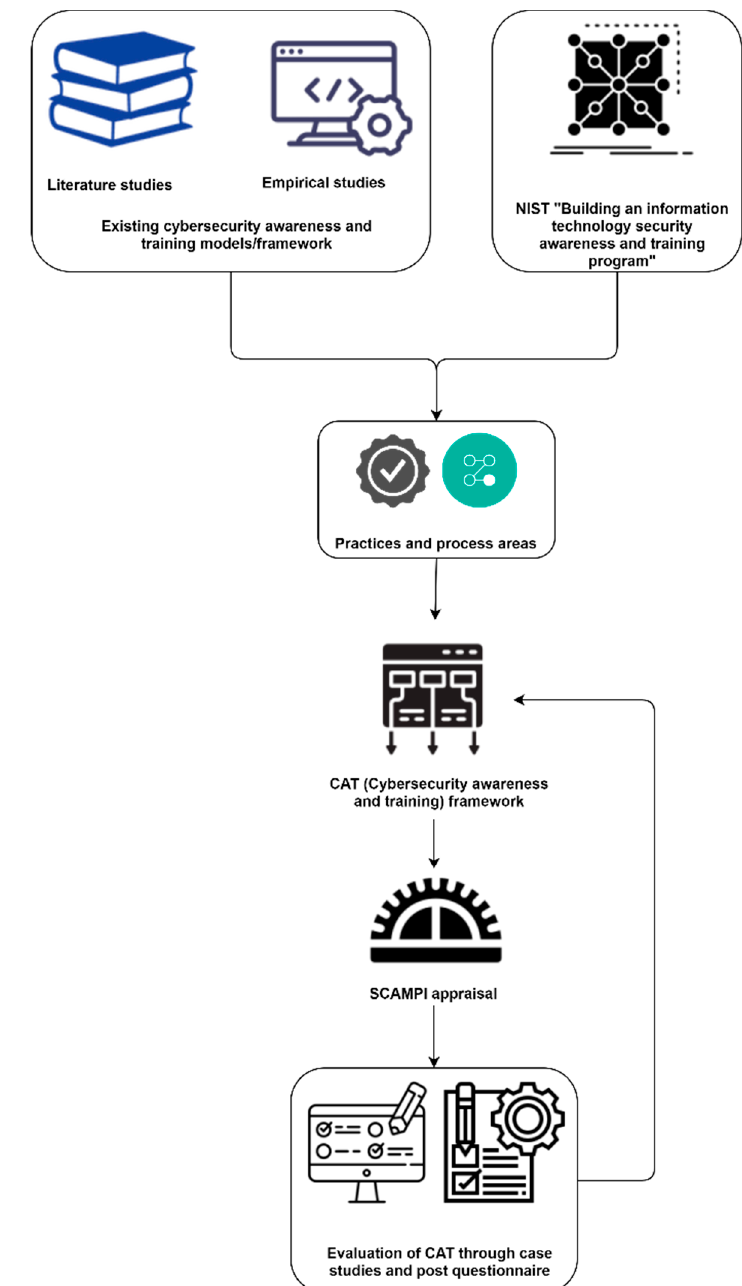
Figure 2. Complete development process of CAT .